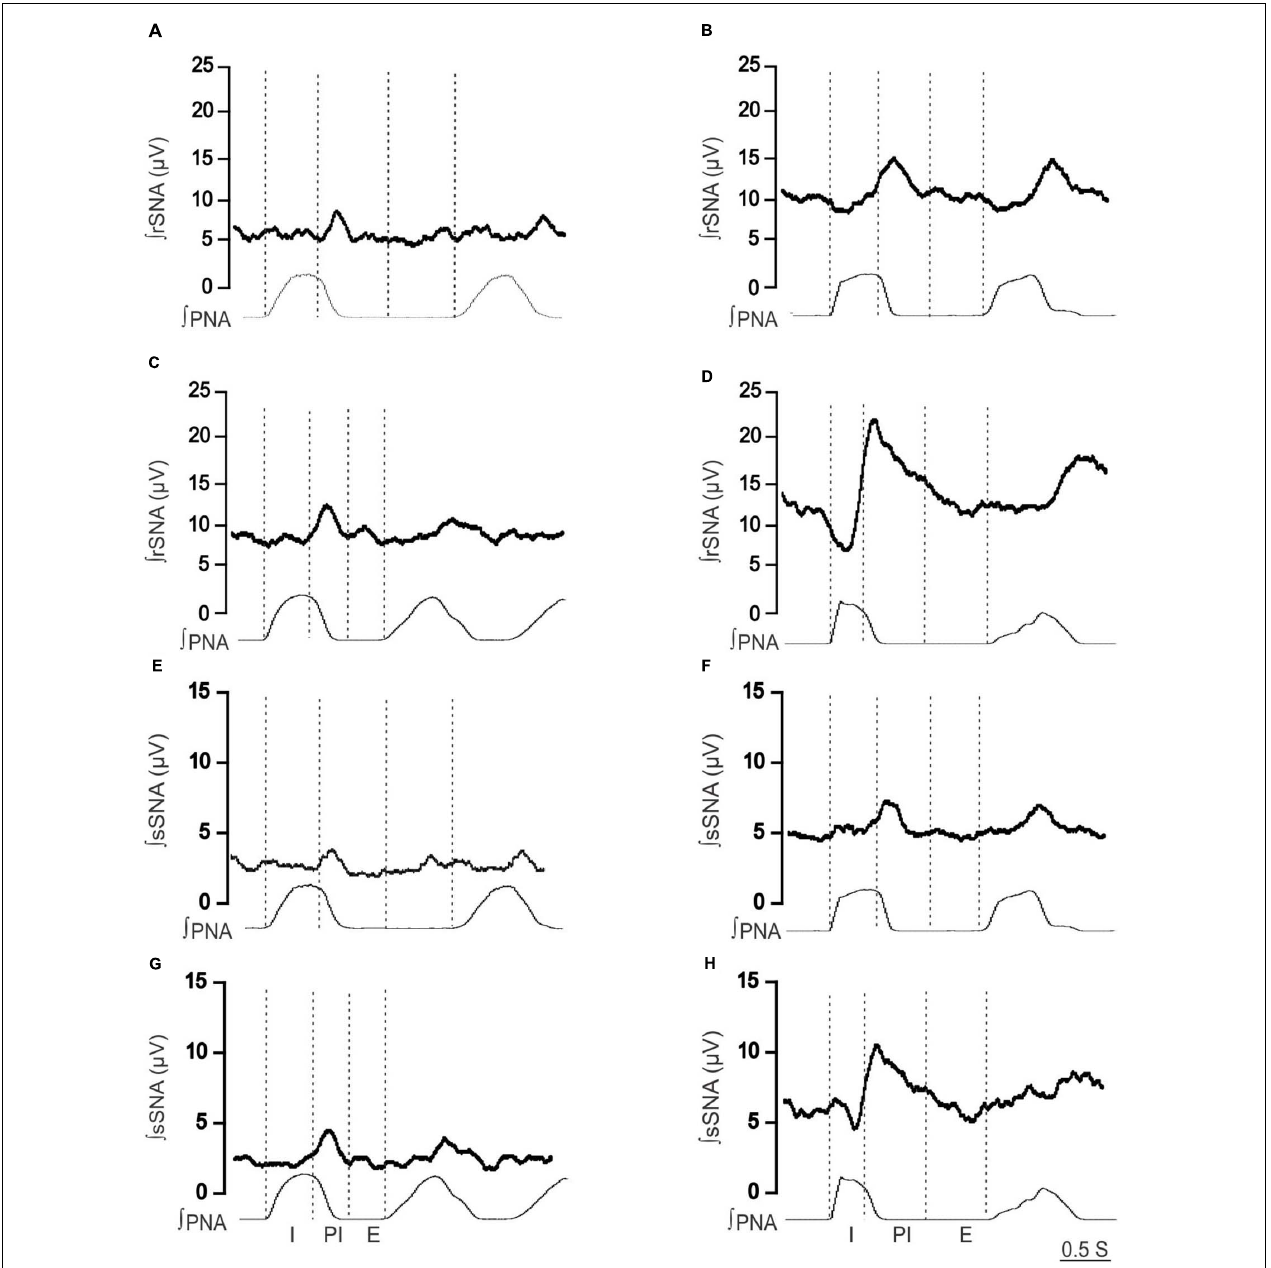
FIGURE 2 | Effect of hypoxia on respiratory-related sympathetic nerve activity in adult female Lewis and LPK rats. Phrenic-triggered ensemble averages of renal sympathetic ( R rSNA) and splanchnic sympathetic nerve activity ( R sSNA) during different phases of the phrenic cycle (I, inspiration; PI, postinspiration; E, expiration) under control (A,B,E,F) and hypoxic conditions (C,D,G,H) in a Lewis rat (A,C,E,G) and LPK rat (B,D,F,H)